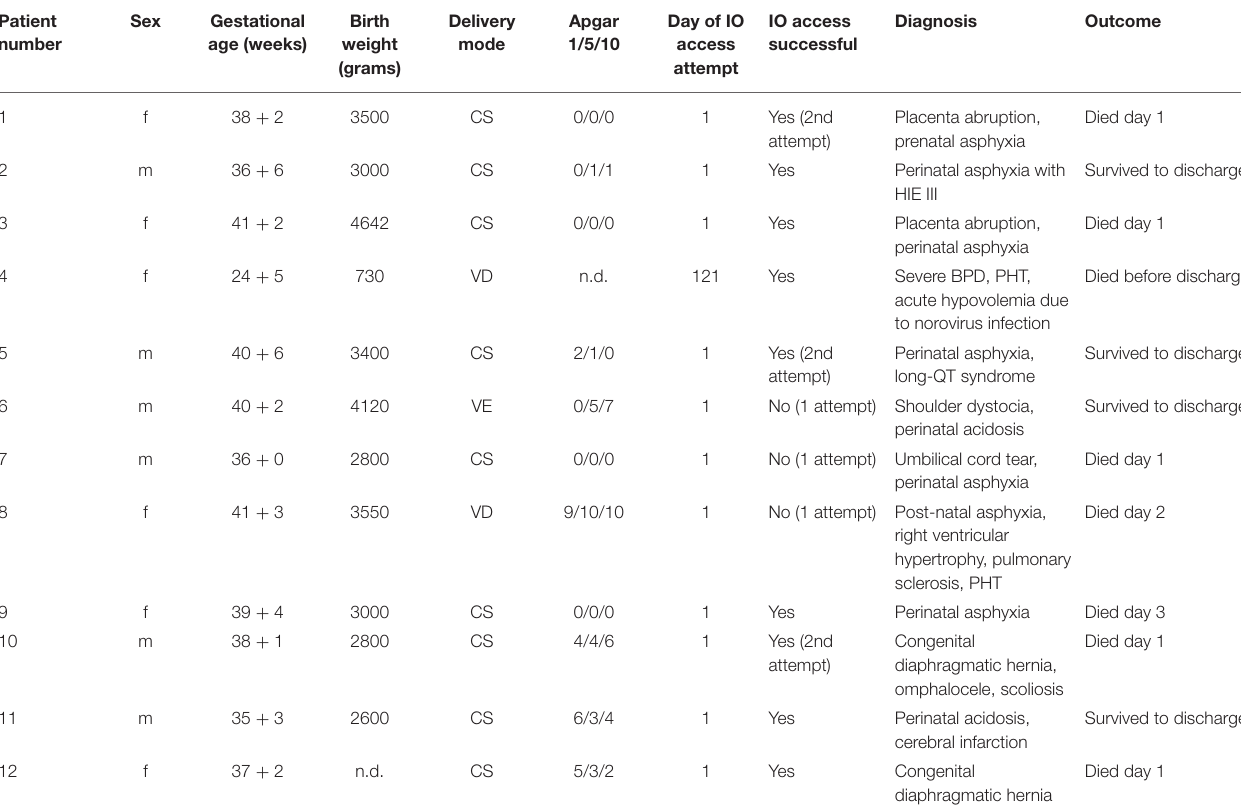
TABLE 1 | Demographic data and clinical characteristics of analyzed neonates. Patient